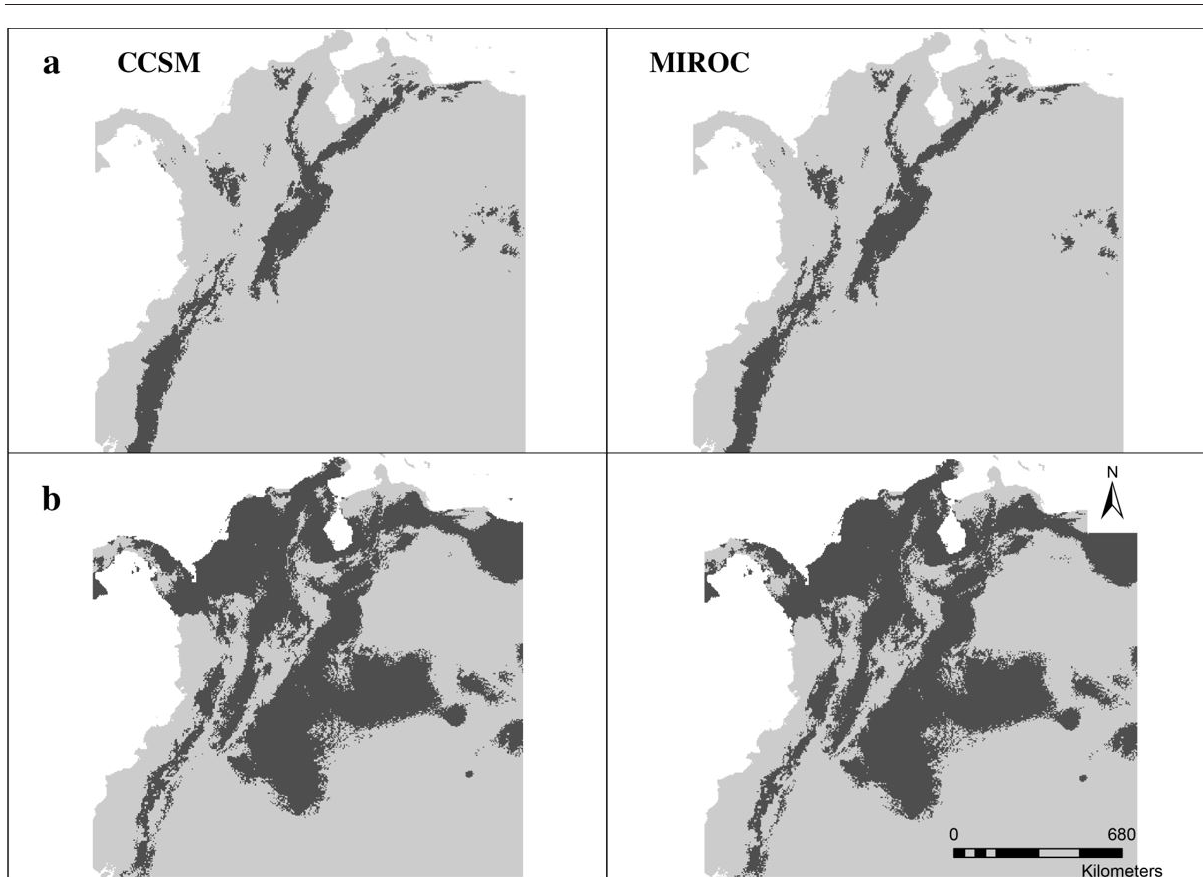
Figure 5. Maps representing areas of stability (presence both in the present and the LGM projection) in dark grey for a representative montane species and a representative lowland species, top a) Dendropsophus molitor and bottom b) Leptodactylus fuscus . Maps on the left represent stability using the Community Climate System Model (CCSM) projection and on the right using the Model for Interdisciplinary Research on Climate (MIROC) projection. To obtain stability areas, species distribution models and both projections to the last glacial maximum were made into binary maps using the 10 th percentile training presence threshold (see Methods). Stable areas were those in which the species is predicted to be present during both the present and the past